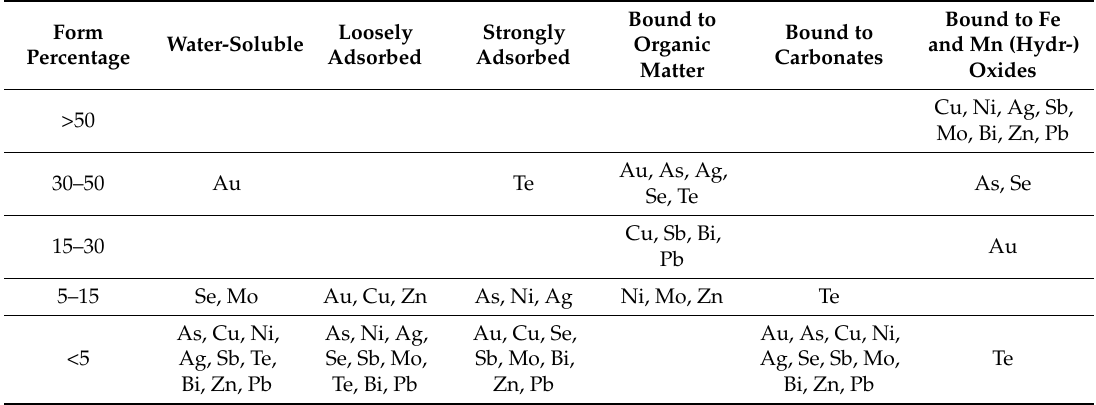
Table 4. Mobile forms of gold and pathfinder elements in surface sediments at Novye Peski.